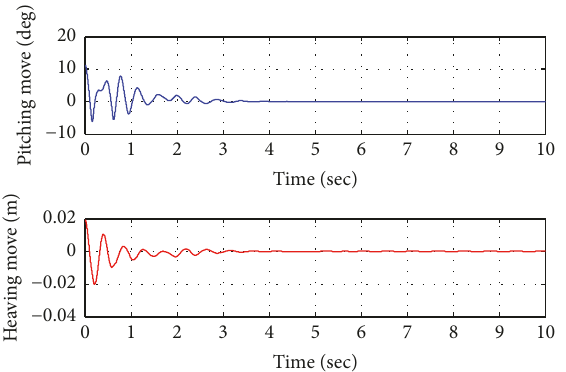
Figure 12: Oscillation control of a two-dimensional wing via PWPF modulator for a short time, from 𝑡 = 0s and 𝑡 = 10s (according to Table 2). Table 2: Parameters for a thin symmetrical airfoil from [7].